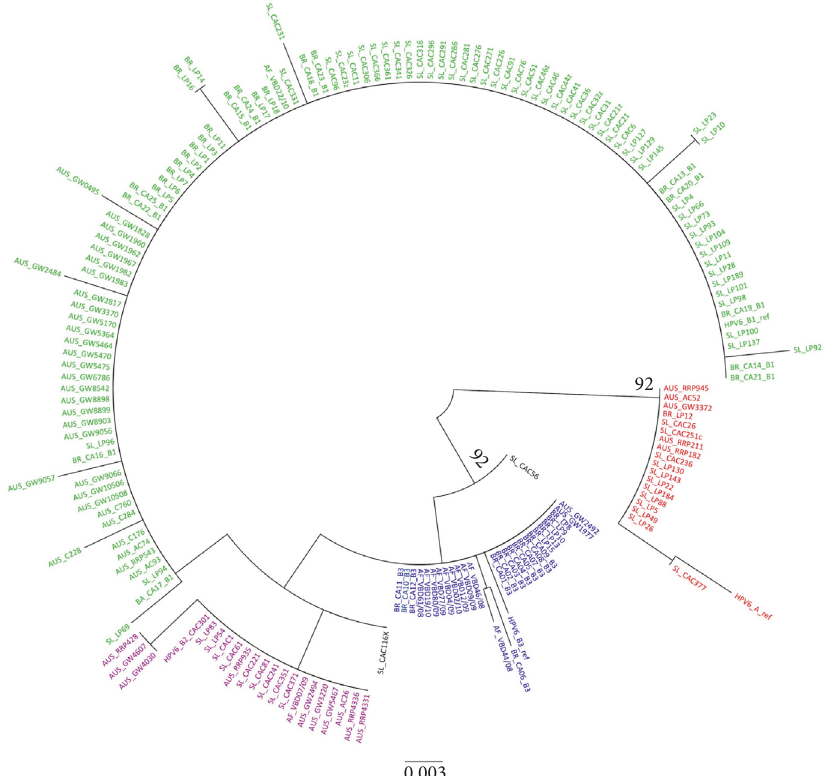
Figure 1: Unrootedmaximumlikelihood phylogenetic treefor HPV6variants reconstructedbased on a datasetof 184 nucleotidesequencesof 453residueswiththeTrN+I+Gsubstitutionmodelandabootstrapof1000replicates. Valuesabove70%wereconsideredsignificant. (African variants: AF; Australian variants: AUS; Brazilian variants: BR; Slovenian variants: SL.) Red: HPV6A; green: HPV6B1; purple: HPV6B2; blue: HPV6B3. Sequences in black are HPV6B that cannot be classified into